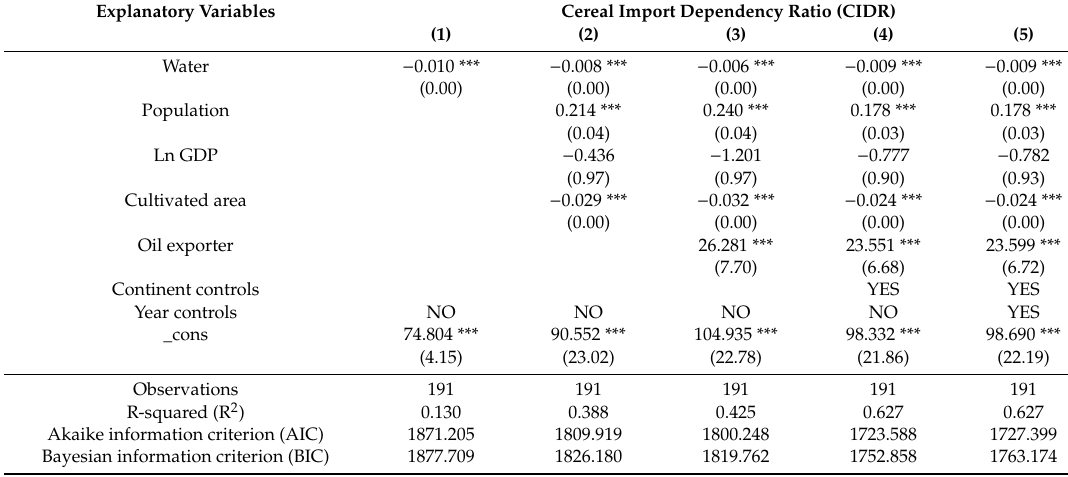
Table 2. Ordinary least squares (OLS) estimations of the relationship between a country’s total renewable water resources per capita and the cereal import dependency ratio (CIDR).